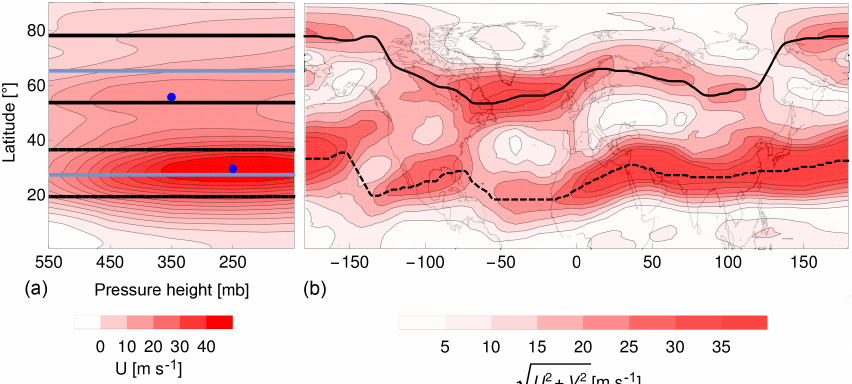
Figure 6. Fifteen-day running mean around 2 March 1979. The right panel shows three maxima (30, 50 and 75 ◦ N); because of those three maxima, the mean jet stream core found with Dijkstra’s algorithm (light-blue line) does not match with the jet stream core found by Rikus’ algorithm (blue